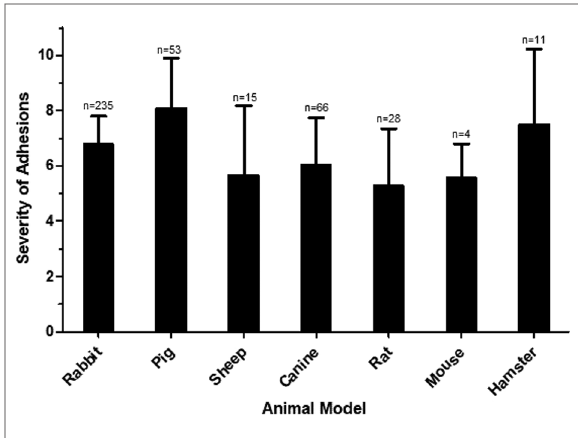
FIGURE 2 Severity of adhesions in various animal models. The mean severity score for each animal model is shown, with error bars representing standard deviation. N represents the number of animals used in each model.